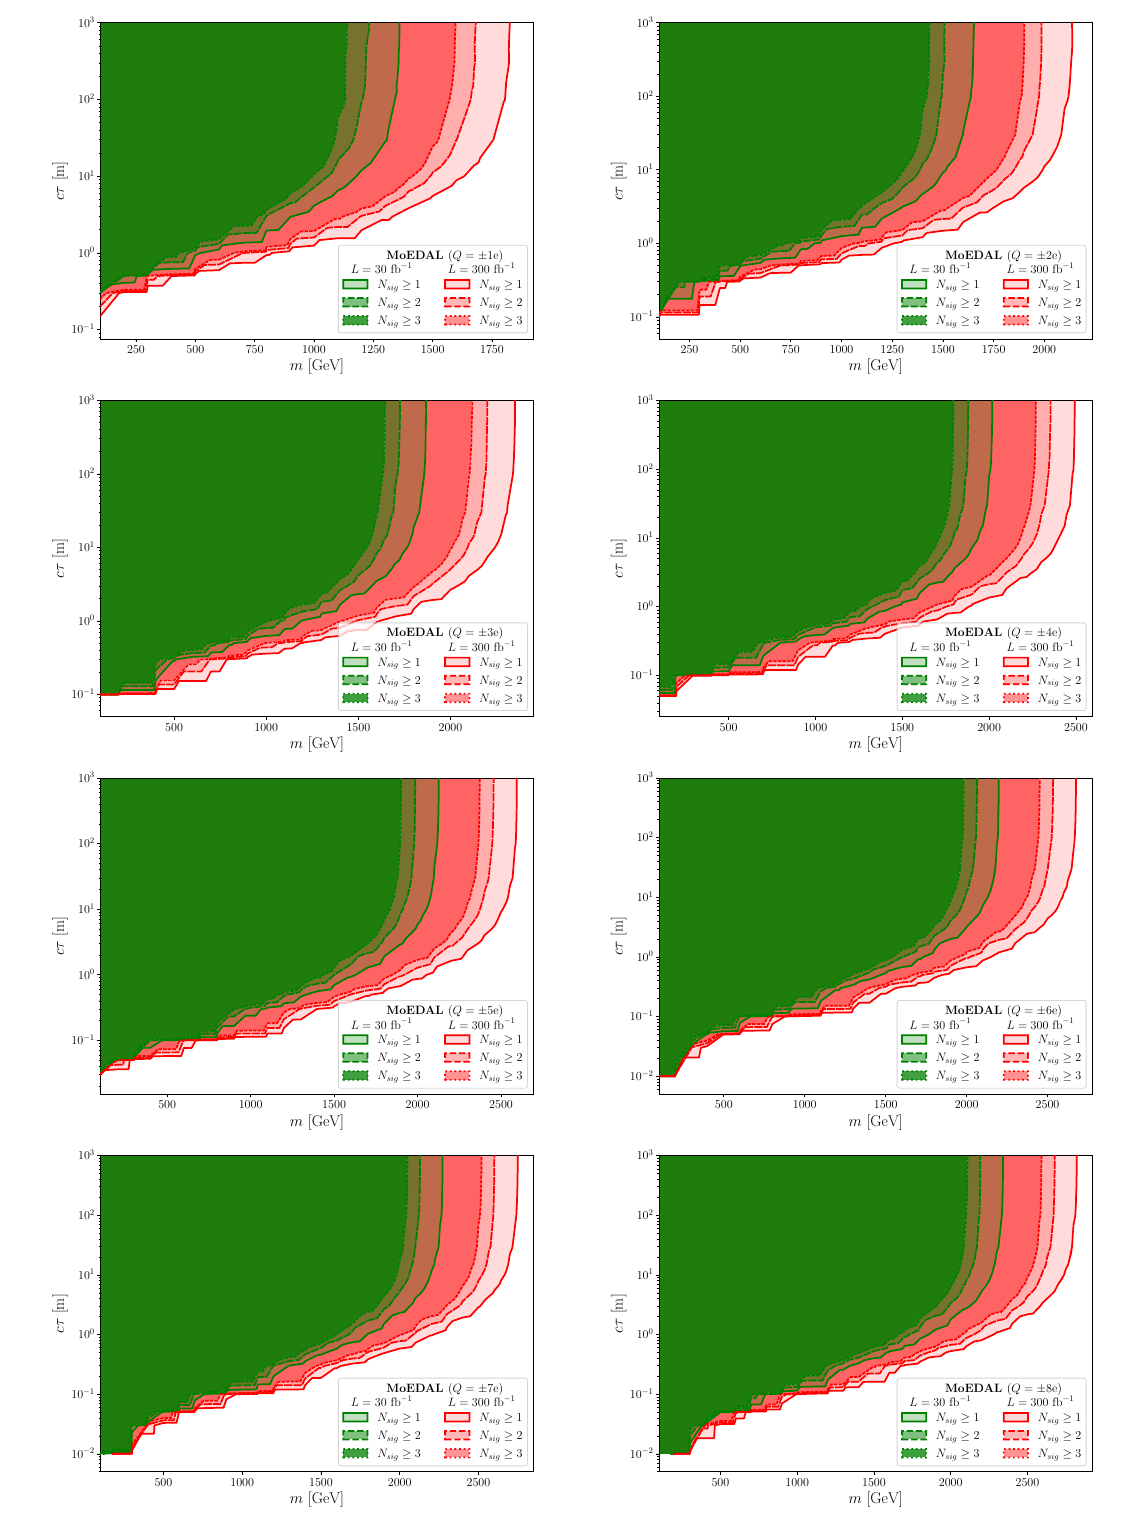
Fig. 18 Model-independent detection reach at MoEDAL in the ( m , c τ ) parameter plane for coloured fermions. The solid dashed and dotted contours correspond to N sig = 1, 2 and 3, respectively. Green and red contours correspond to Run-3 ( L = 30 fb − 1 ) and HL-LHC ( L = 300 fb − 1 ) luminosities